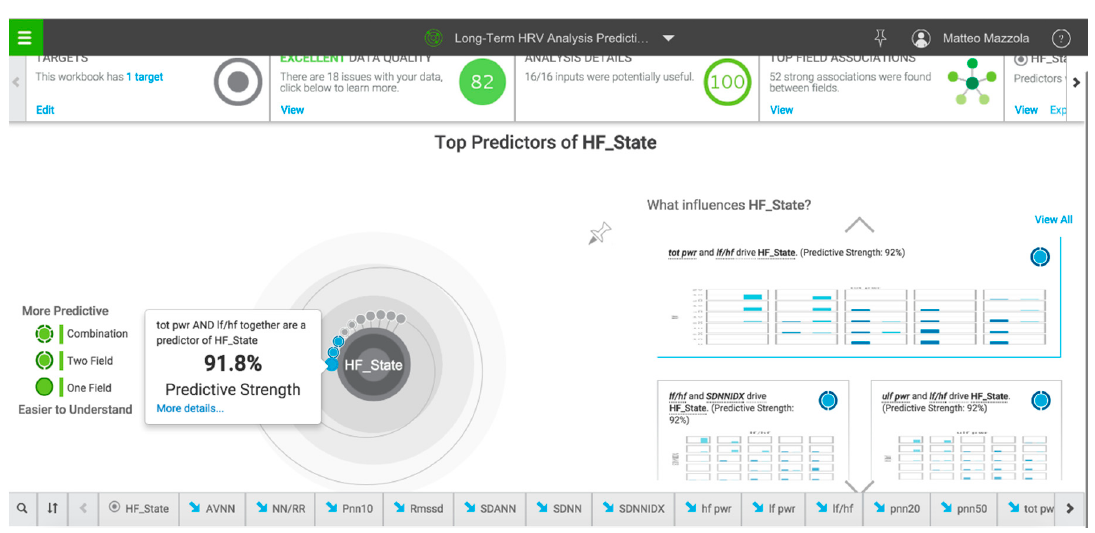
Figure 9. WA has automatically selected logistic regression as the best model to deal with our data.